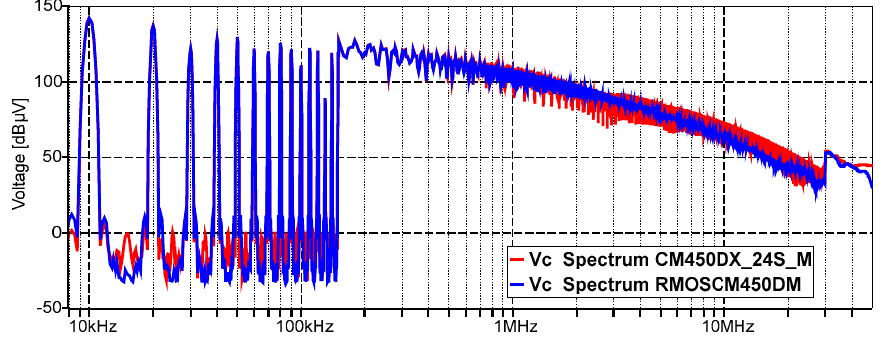
Figure 22. Collector voltages spectrum with R4 = R3 = 1 (Figure 19).